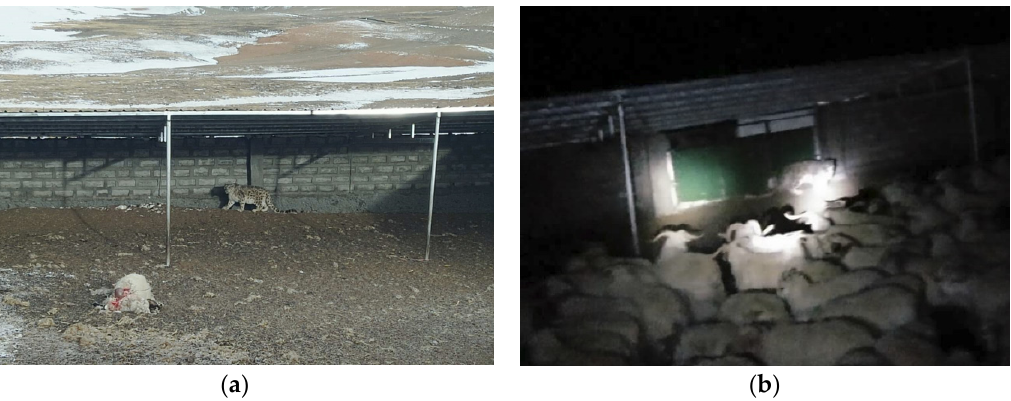
Figure 4. Photo records of snow leopards breaking into human settlements. ( a ) Occurred in the day; ( b ) Occurred in the night.